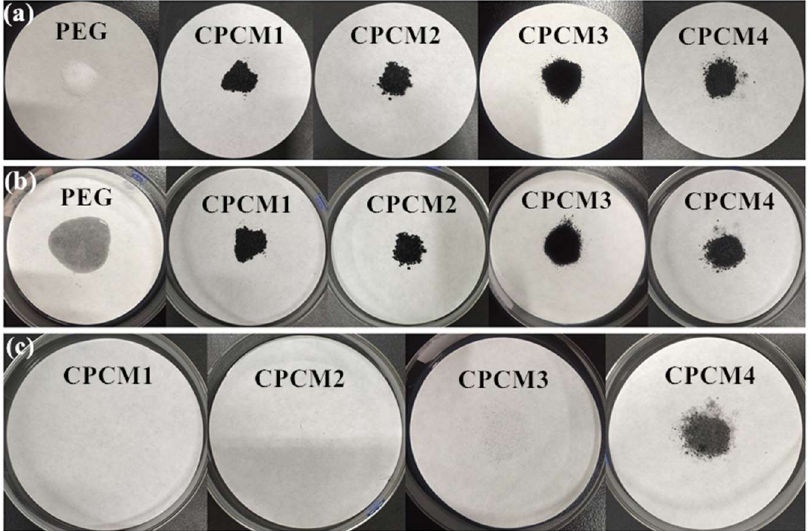
Figure 3. Leakage test of polyethylene glycol (PEG) and composite phase change materials composed PEG and ASB (PEG/ASB CPCMs); ( a ) pictures of samples at indoor temperature; ( b ) pictures of samples after leakage tests; ( c ) pictures of leakage trace after the removal of samples.